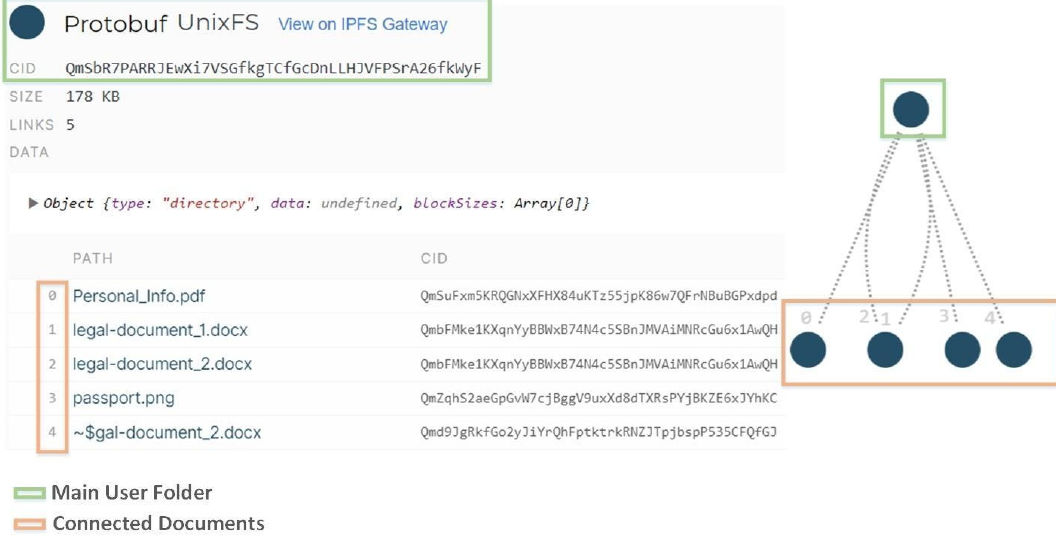
Figure 3. IPFS content-addressed file system.